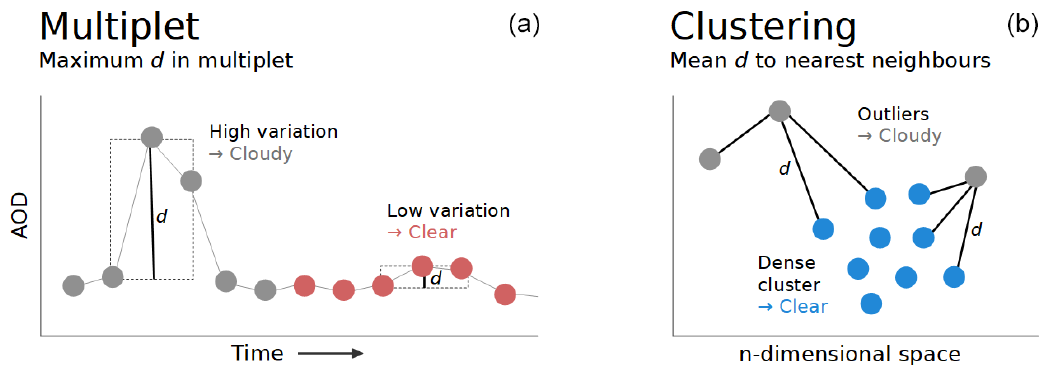
Figure 1. Schematics of the cloud screening methods. (a) The Multiplet method evaluates the difference between the maximum and minimum AOD value of a set number of consecutive data points. (b) The Clustering method calculates the mean distance to k nearest neighbours in an n -dimensional space. Points for which a certain threshold of the respective measure d (indicated with the solid black lines) is passed will be identified as cloudy. These points are coloured in grey, whereas the clear points are coloured red/blue for Multiplet/Clustering.